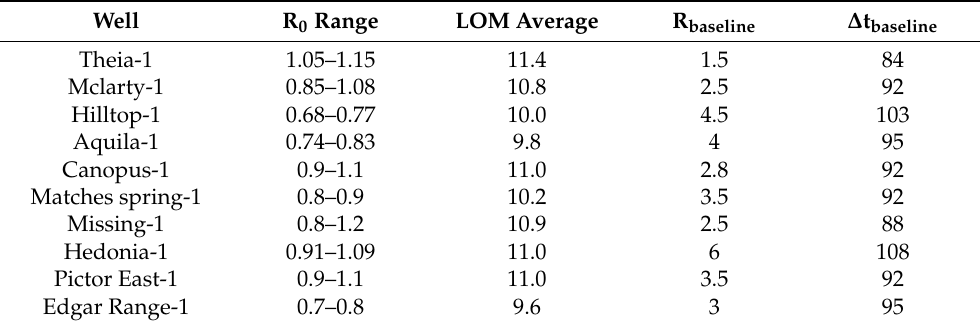
Table 7. Vitrinite reflectance, LOM, resistivity, and compressional sonic travel time baseline value of each studied well in the Goldwyer formation of the Canning Basin.